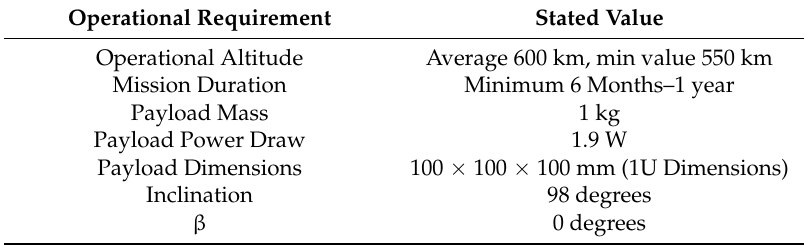
Table 1. Summarizes the key numerical values presented in Section 2.4, Mission and Payload Specification.